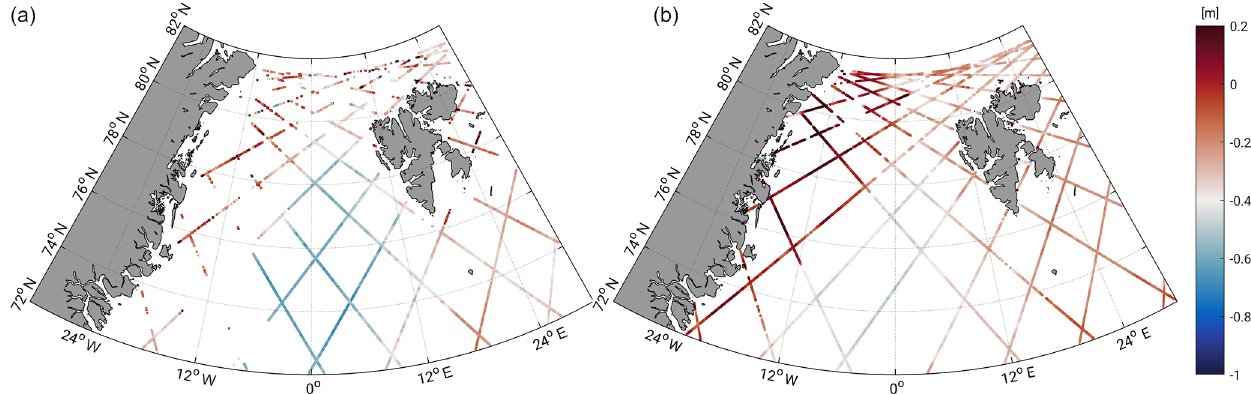
Figure 2. Exemplary pre-processed altimetry along-track DOT estimates for Envisat 3d subcycle in March 2004 (a) and July 2006 (b) , illustrating season-dependent data coverage.